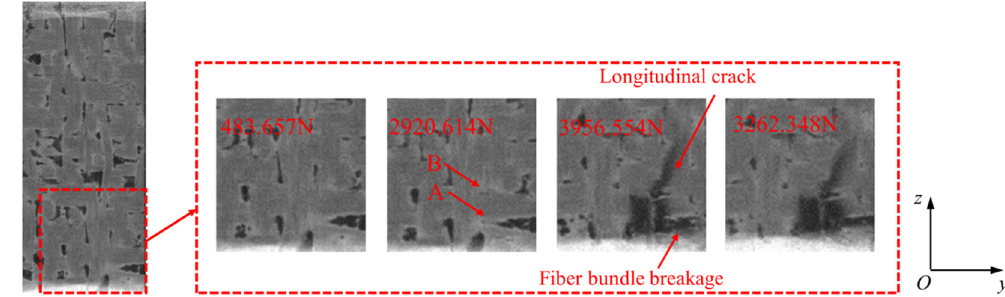
Figure 6: Damage evolution process of local area on ZOY cross -